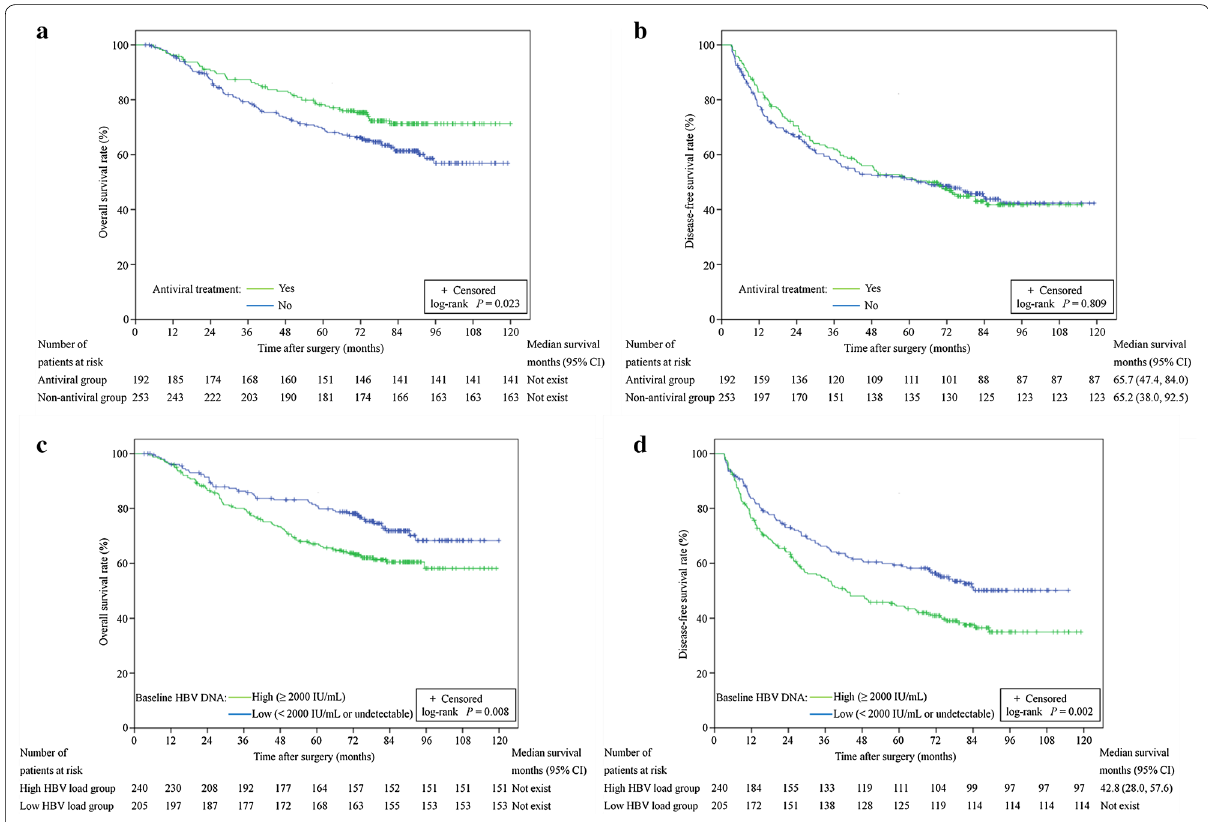
Fig. 3 Kaplan–Meier survival curves of patients with various baseline HBV levels and use of nucleotide/nucleoside analogs (NAs). a OS rates between the antiviral and non‑antiviral groups. b DFS rates between the antiviral and non‑antiviral groups. c OS rates between patients with baseline serum HBV DNA levels of 2000 and <2000 IU/mL or undetectable. d DFS rates between patients with baseline serum HBV DNA levels of ≥ 2000 and <2000 IU/mL or ≥